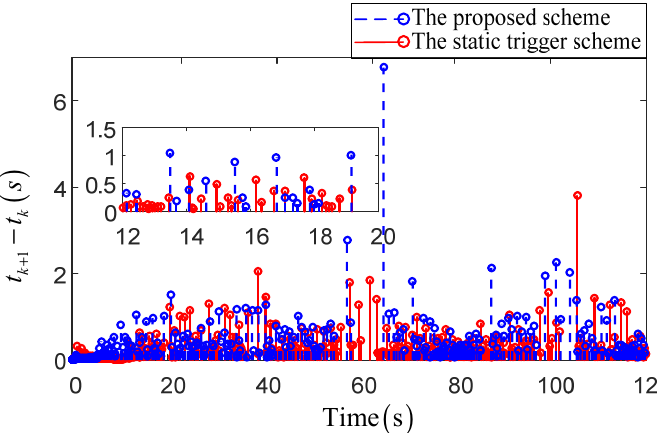
Figure 12. The comparison of the triggered time and triggered interval. Table 3. The main comparison results for two algorithms.